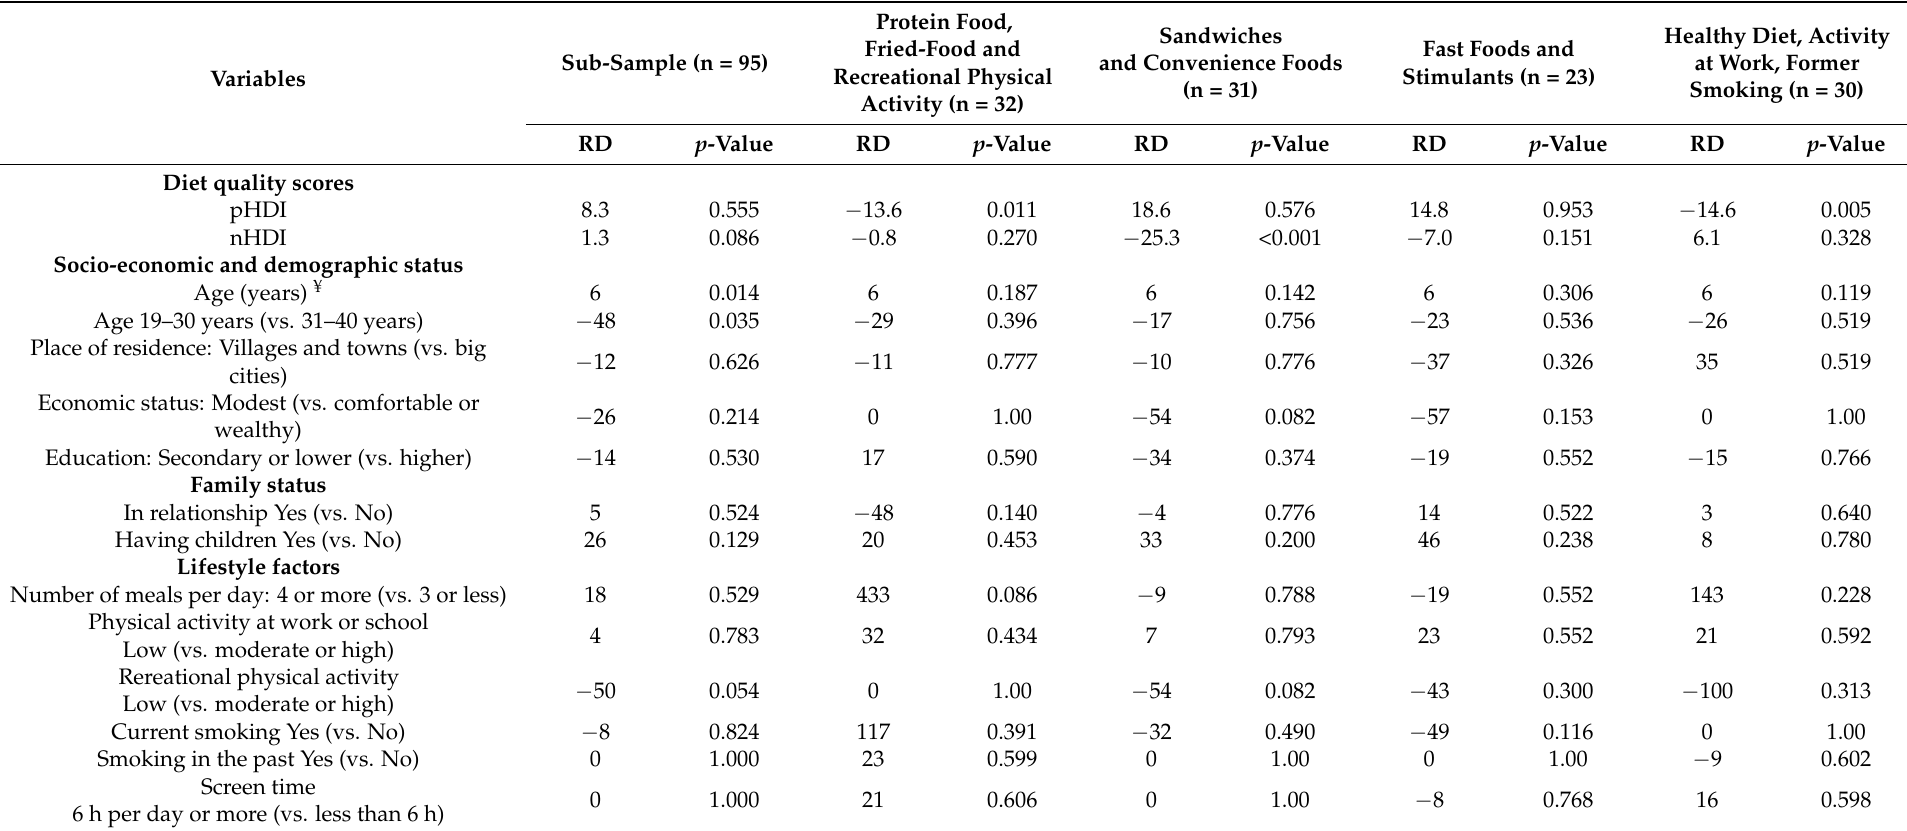
Table 2. Relative differences (RD, %) for means or % of the sample within sub-sample with higher adherence to each pattern in family socio-economic and demographic status, by dietary lifestyle patterns # : before vs. 2 years